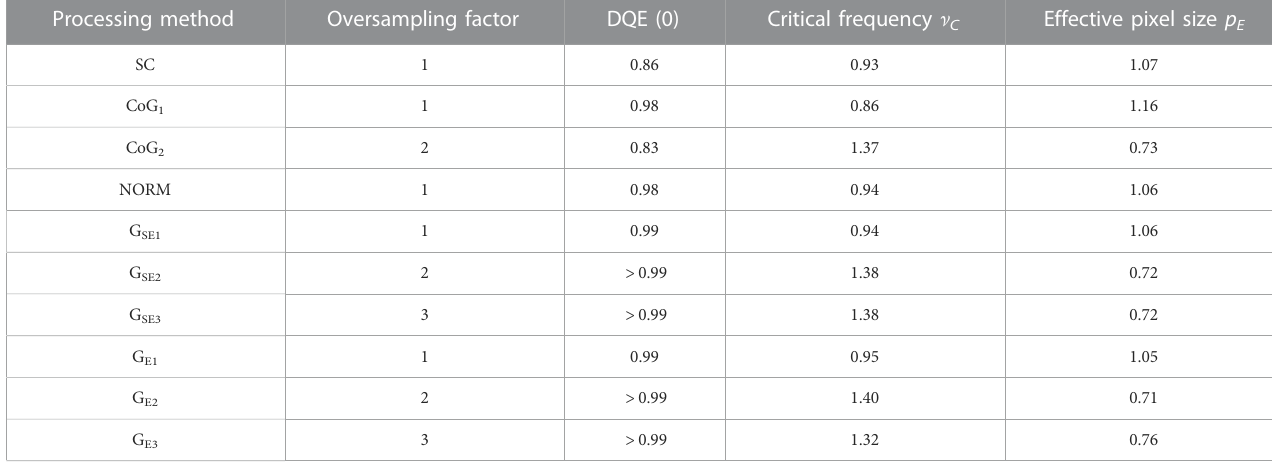
TABLE 1 Summary of the probed fi lters. Lengths are expressed in the physical pixel unit, and frequencies are expressed in the physical Nyquist unit . Processing